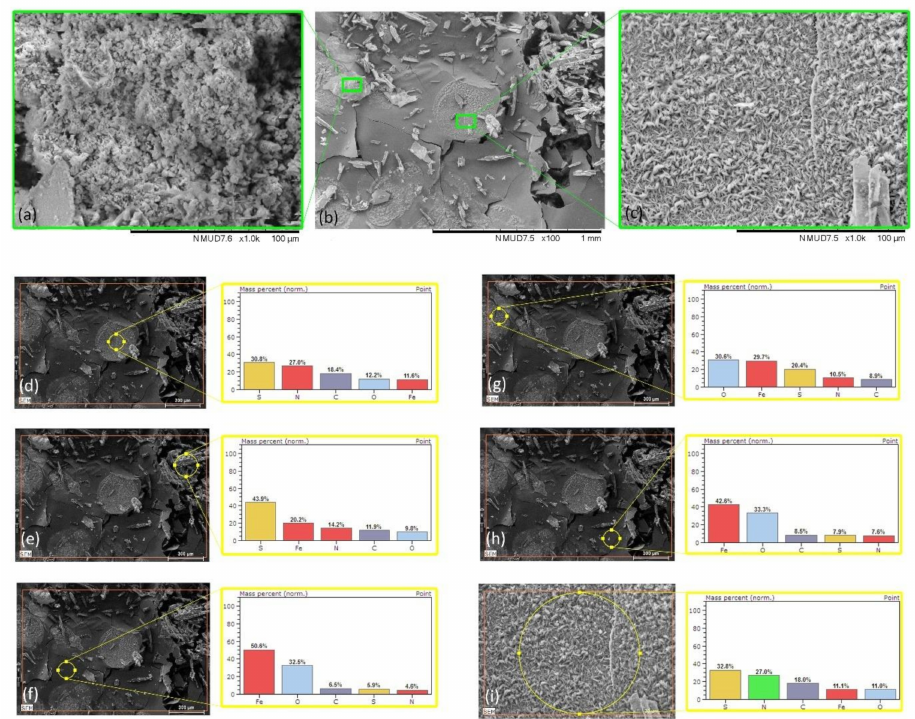
Figure 7. ( a – c ) SEM images and the corresponding ( d – i ) EDS analyzes of mild steel immersed into 3.5 wt.% NaCl for 144 h in the presence of Ce x Ti y O z nanocontainers loaded with ATT (Mild